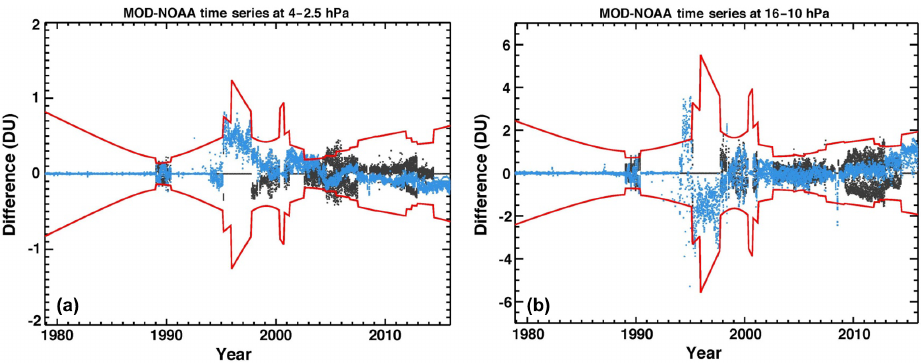
Figure 10. Time series showing MOD/NOAA Cohesive data set differences at two pressure levels (4–2.5hPa in a and 16–10hPa in b ). Black dots are MOD minus individual SBUV monthly mean differences, defined during times when more than one SBUV instrument contributes to MOD; blue dots are MOD minus NOAA Cohesive monthly mean differences. Both are generally contained within the 2 σ variability. Differences in all latitude bands from 50 ◦ S to 50 ◦ N are included. The red lines indicate 2 σ variability of 10000 Monte Carlo simulations.